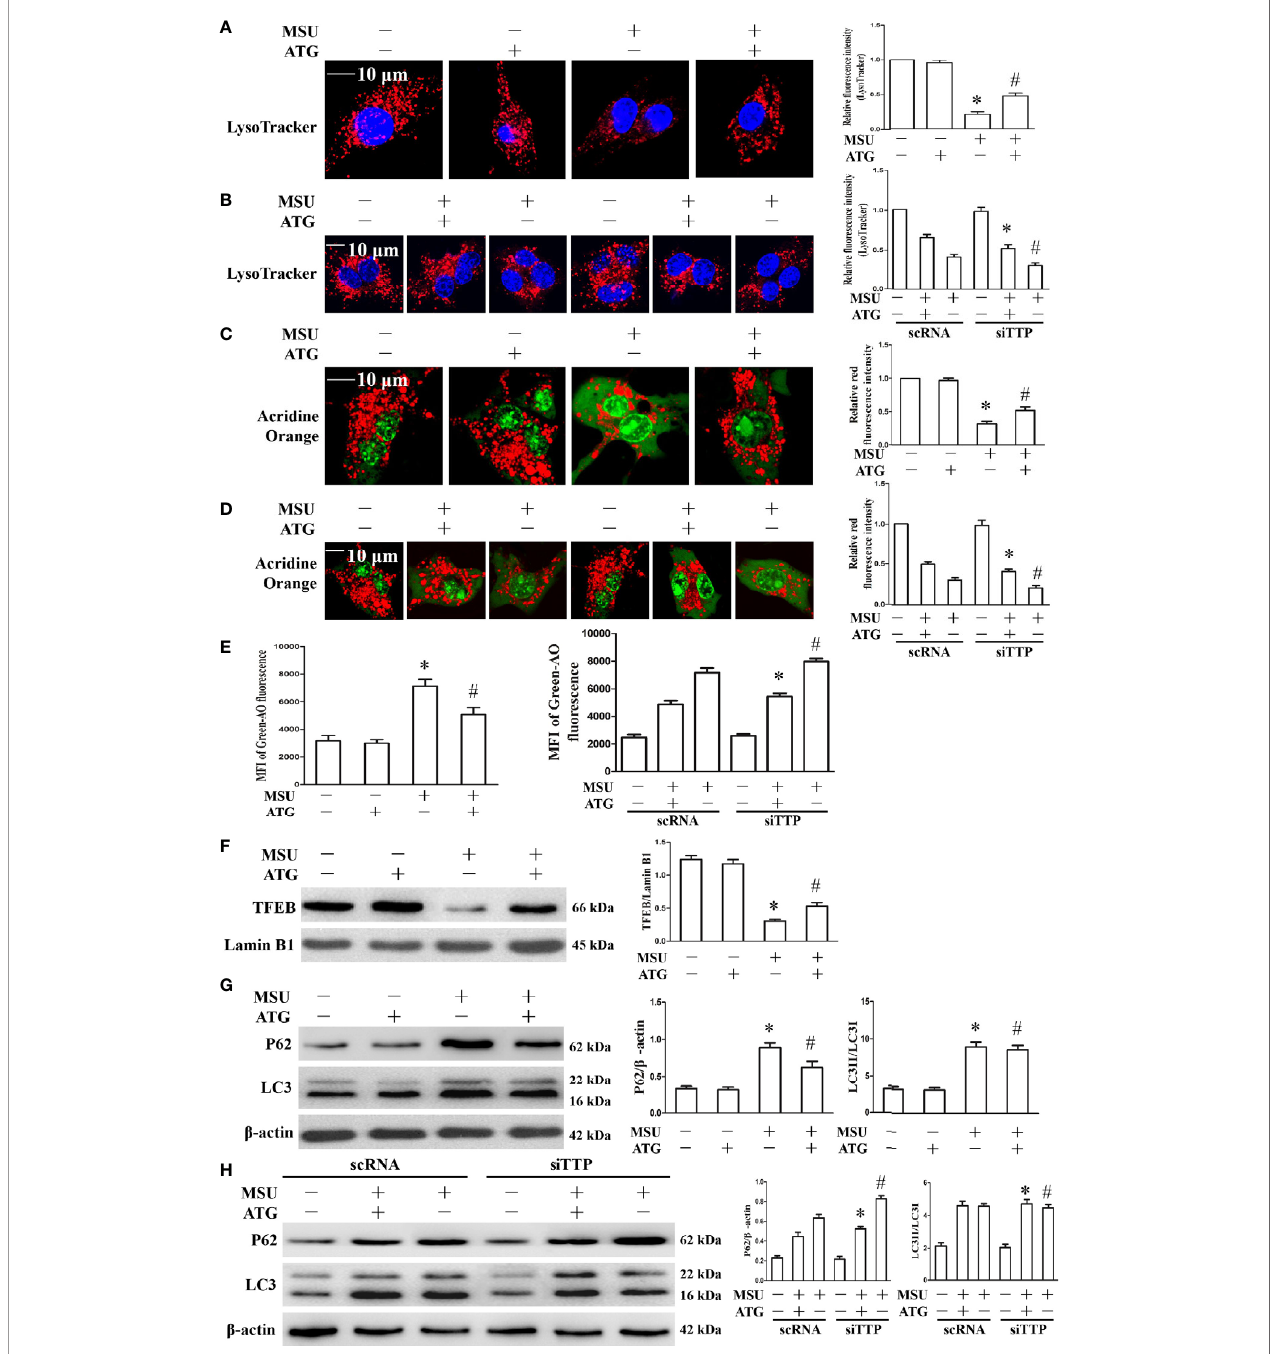
FIGURE 7 | Effects of ATG treatment or TTP knockdown on MSU crystal-induced lysosomal rupture, lysosomal biogenesis and autophagic fl ux in J774A.1 cells. (A, C, E – G) J774A.1 cells were pretreated with ATG (5 m M) for 1 h, primed with LPS for 1 h and then treated with MSU crystals (50 m g/ml) for 9 h. *P < 0.05 vs. without MSU crystals treatment; # P < 0.05 vs. MSU crystals treatment +vehicle. (B, D, H) J774A.1 cells were either transfected with scRNA or siTTP for 48 h, treated for 1 h with 5 m M of ATG, primed with LPS for 1 h, then stimulated with MSU crystals (50 m g/ml) for 9 h. (A, B) The cells were stained using LysoTracker Red (100 nM, 30 min) and then with Hochest 33342 (20 m g/ml, 15 min). Images were captured by Laser confocal microscope. Scale bar: 10 m m. (C – E) cells were incubated with AO for 30 min, and then images were captured by Laser confocal microscope or green fl uorescence intensity of AO was determined by a microplate reader. Scale bar: 10 m m. (F) Western blot analysis of TFEB level in nuclear proteins. (G, H) Western blotting was used to measure the LC3II and P62 protein levels. The LC3II and P62 protein levels were measured by Western blot assay. *P < 0.05 vs. MSU crystals treatment + ATG + scRNA; # P < 0.05 vs. MSU crystals treatment + scRNA. All the data are expressed as the means ± SEM from n=3 independent